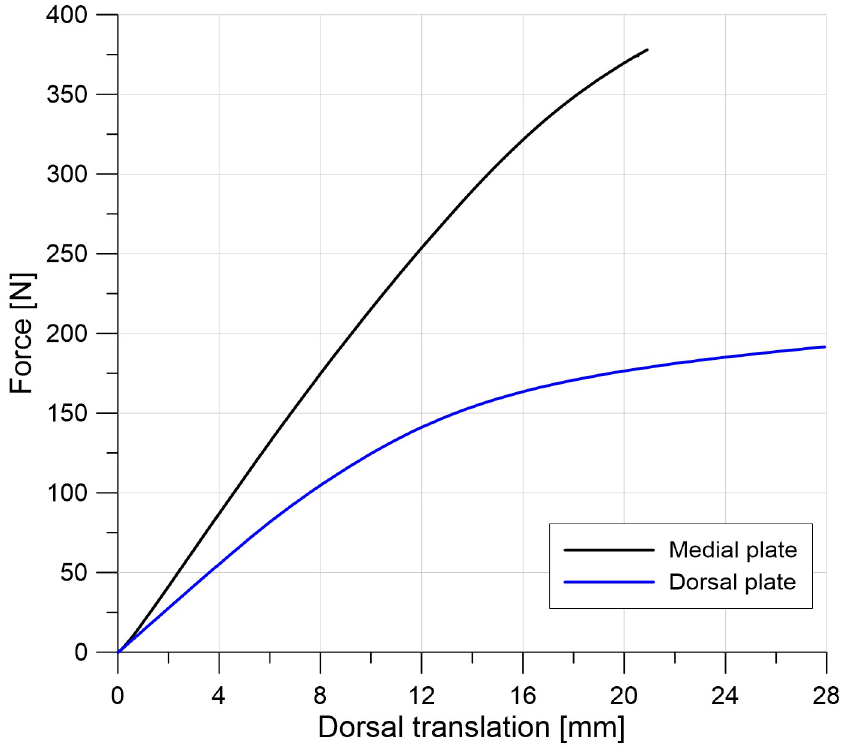
Fig 9. The relationship between the force applied to the FE model and the dorsal translation of point P3 at the distal phalanx (see Fig 4b) for both plate positions.